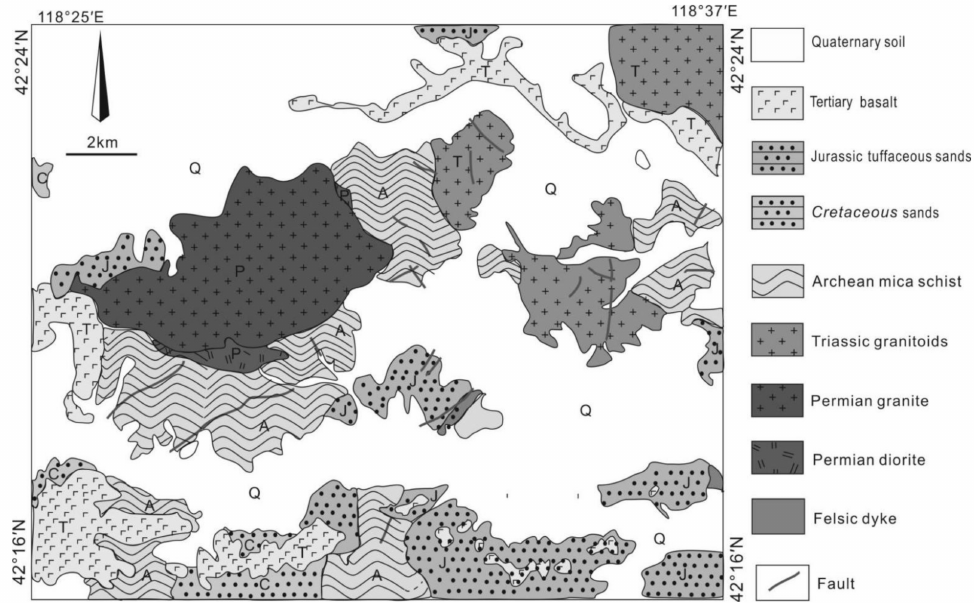
Figure 1. Regional geologic map of Chaihulanzi deposit (Modified by